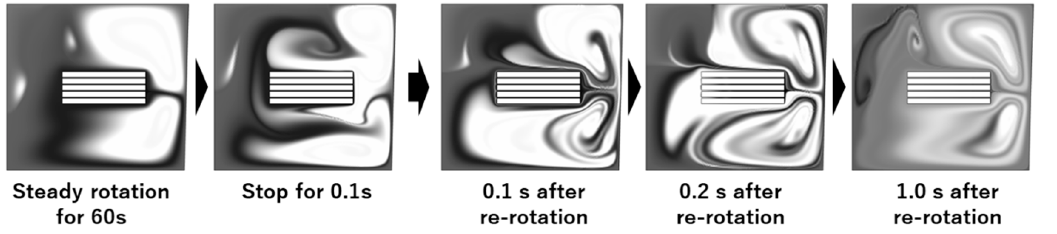
Figure 9. Calculated variation in concentration distributions after stopping the flow in 0.1 s and re- rotation.